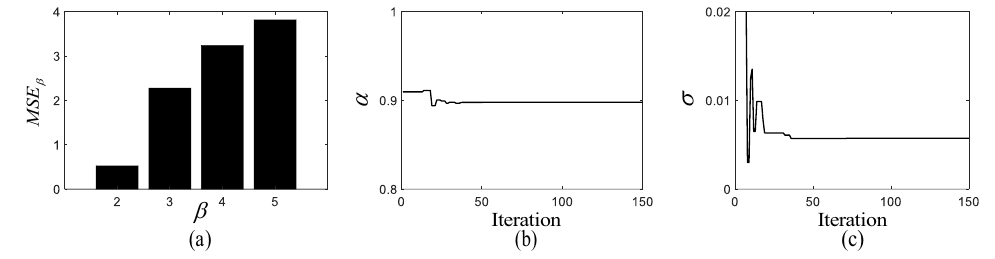
Figure 8. Estimation results: ( a ) Estimate of β . ( b ) Estimate of α . ( c ) Estimate of σ . Table 5. Comparison of degradation model coefficients estimation